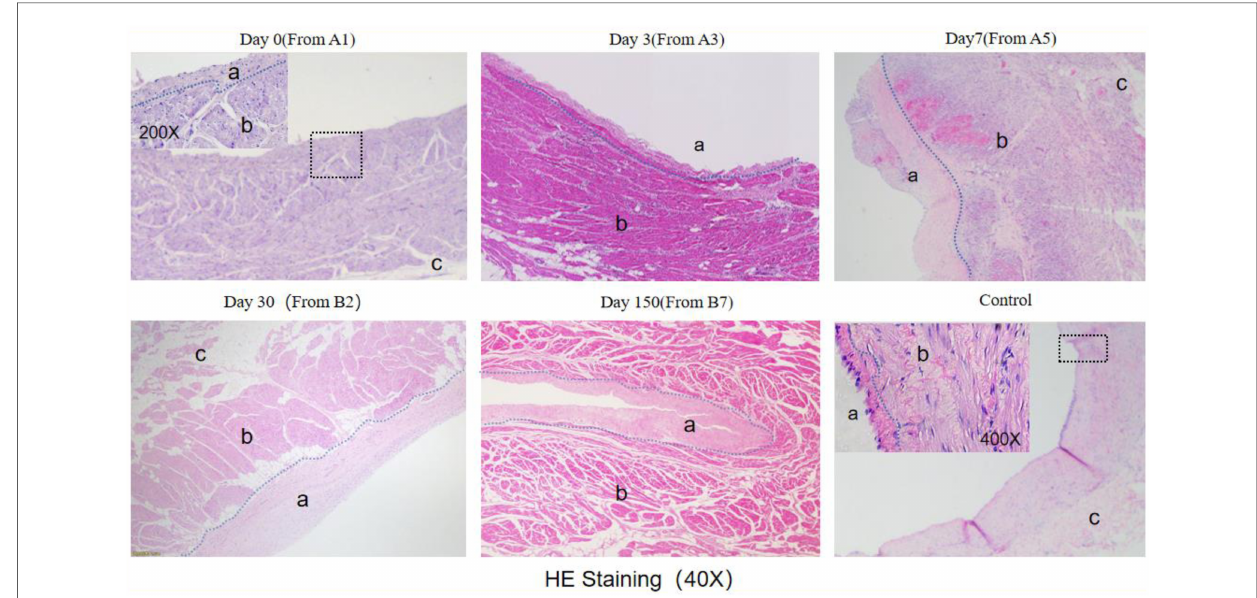
FIGURE 7 He staining results (observed under 40X microscope).The blue dashed line indicates the boundary between the endomyocardial intima and myocardial cells, with "a" marking the endomyocardial region, "b" marking the myocardial cell region, and "c" marking the epicardial region. The endomyocardial region in both the Day0 and control groups is small and dif fi cult to distinguish under 40X magni fi cation. The black wireframe region in the Day0 fi gure was observed under 200X magni fi cation, while the black wireframe region in the control group was viewed under 400X magni fi cation. The junction between the endomyocardial intima and myocardial cells is highlighted with a blue dashed line.